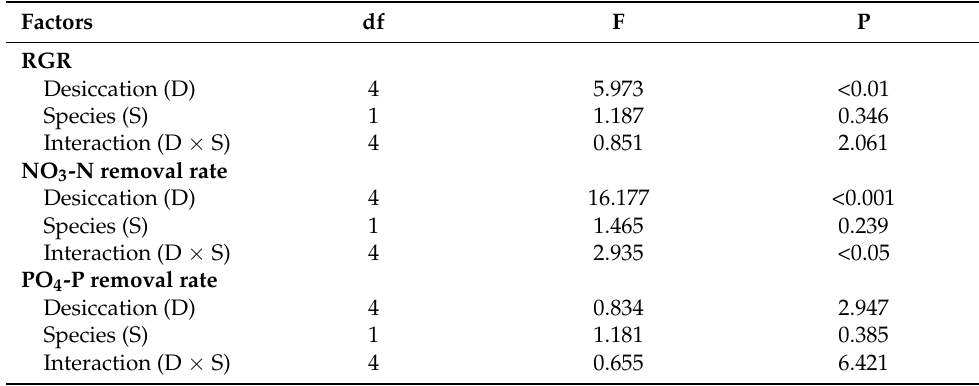
Table 1. Analysis of variance (two-way ANOVA) examining the effects of desiccation on the RGR and NO 3 -N and PO 4 -P removal rates of N. haitanensis and N. dentata , and the comparison of these parameters between the two